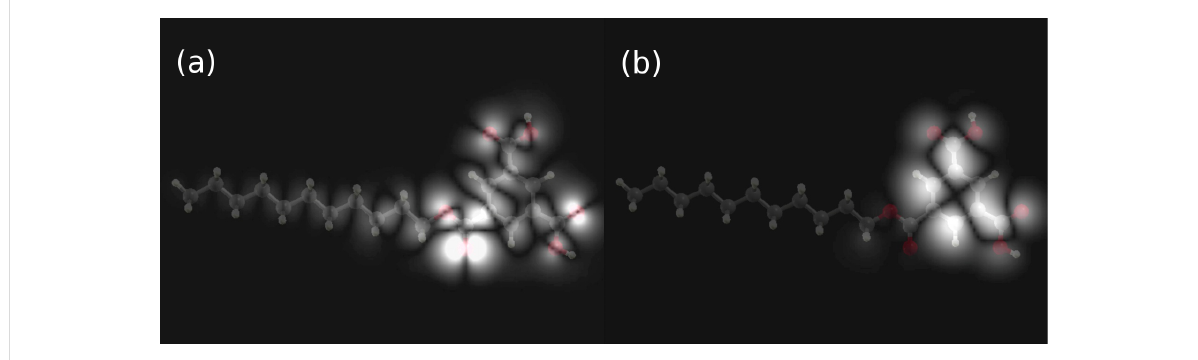
bottom of the vial). The circles depict the location of TMA groups of the synthesized monoester. A and B are the unit cell parameters and θ is the angle between them. α depicts the angle between the molecular unit cell axis A and the pair formed by TMA groups of adjacent monoesters. These quantities are indi- cated in Table 1. The geometrical parameters of the synthesized monoester pattern obtained here are in excellent agreement with those observed for ester type-II formed from the TMA–unde- canol solutions at high sonication or stirring time or enhanced substrate temperature. This experiment establishes that the ob- served close packed patterns (ester type-I and -II) obtained at the TMA–undecanol interface from solutions at high sonication/ stirring time and high substrate temperature are made of monoester molecules.